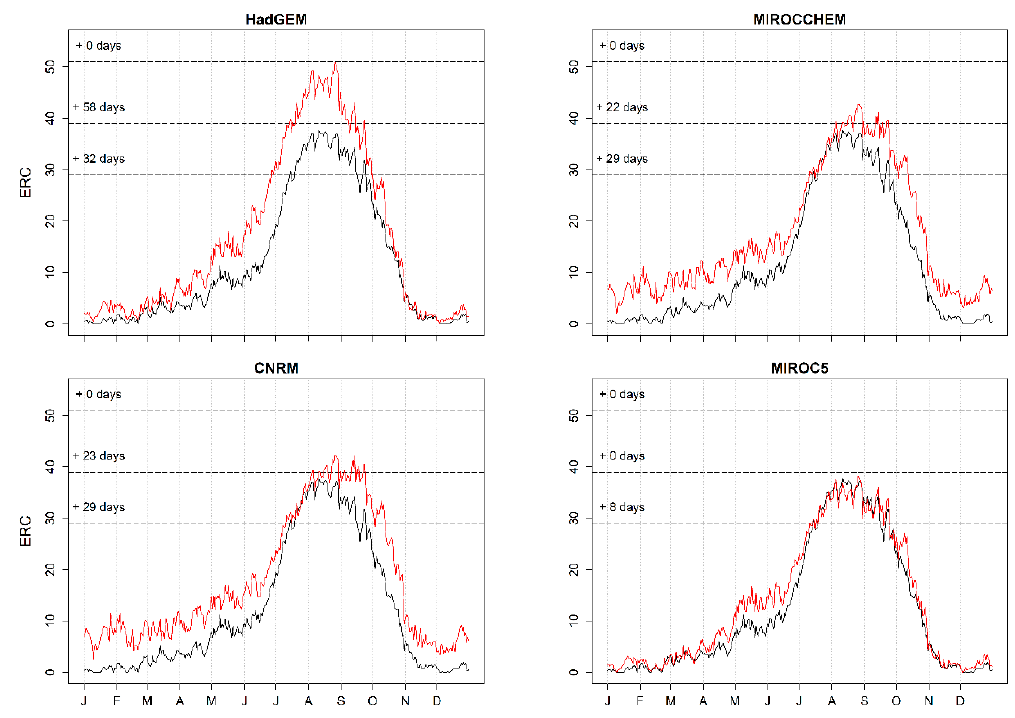
Figure 4. Mean daily ERC values for each future (2040–2069) climate scenario, shown in red, compared to baseline ERC values, shown in black. Dashed horizontal lines reflect the 80th, 90th, 97th, ERC percentiles based on the 1992–2015 baseline climate. Numbers above the dashed lines indicate the number of days additional to baseline during which fire weather exceeds each fire danger rating.